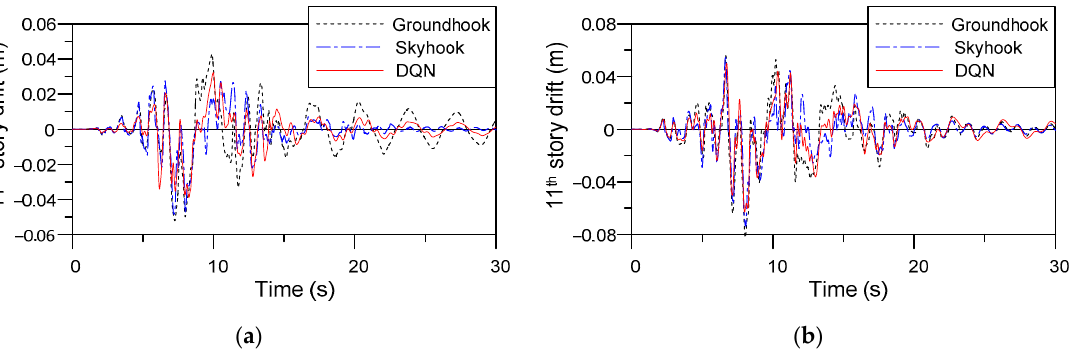
Figure 14. Comparison of the isolation story drift time histories: ( a ) responses to EV1, ( b ) responses to EV2. Figure 13. Comparison of the 11th-story drift time histories: ( a ) responses to EV1, ( b ) responses to EV2.